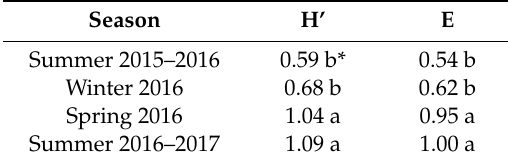
Table 3. Shannon–Weiner diversity index (H’) and genera evenness (E) on earthworms sampled during